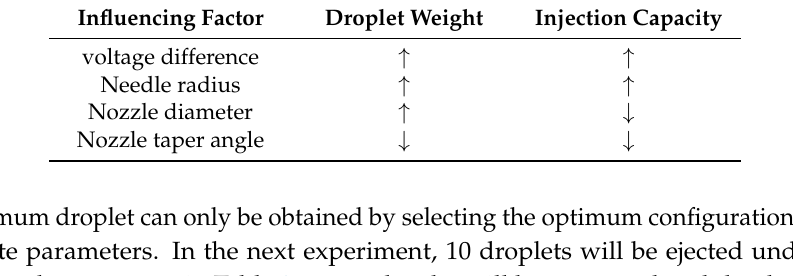
Table 1. Relationship between influencing factors, droplet weight, and injection